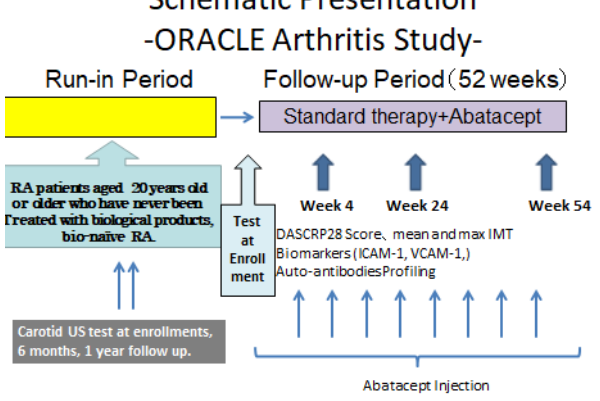
Figure 1. Schematic Presentation of ORACLE Arthritis Study. Table 1. Treatment regimen using the study